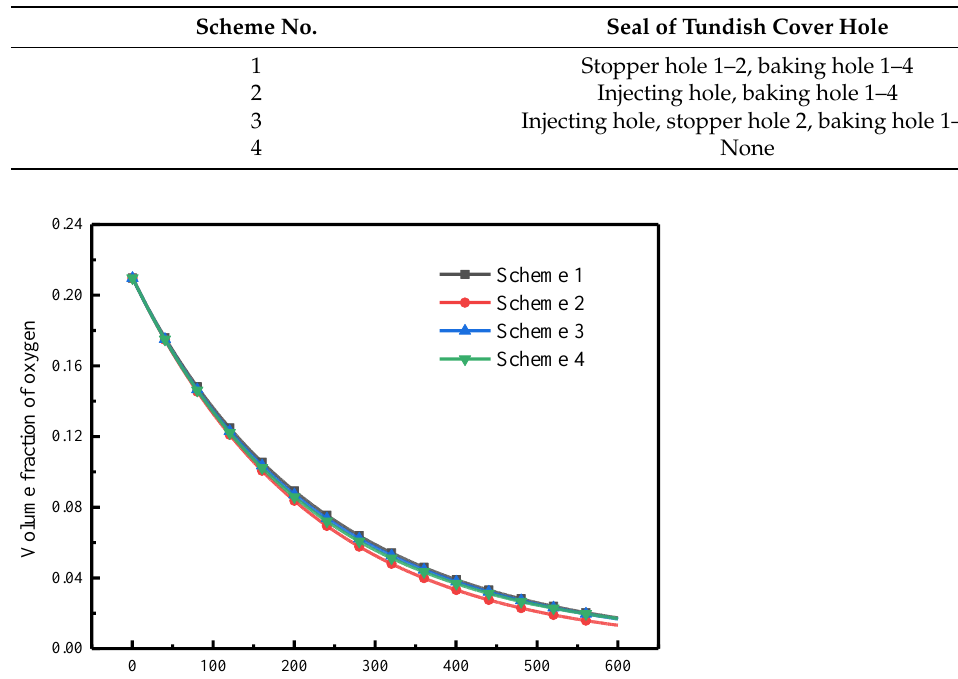
Table 3. Sealing schemes of tundish cover holes.